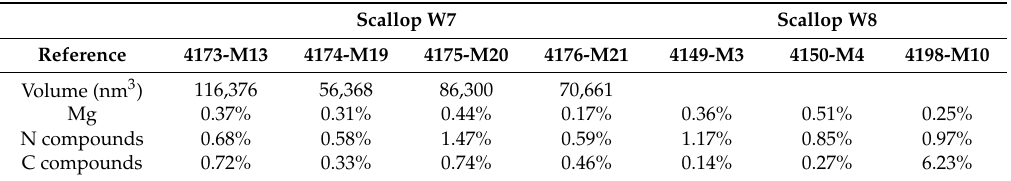
Table 4. Estimation of the concentrations of magnesium, nitrogen (N) compounds, and carbon (C)